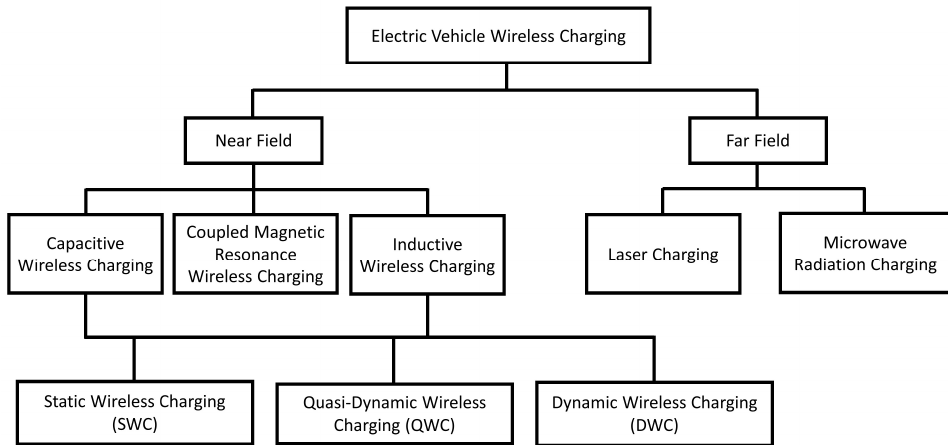
Figure 9. General classification of EVs wireless charging system. Microwave Radiation WPT